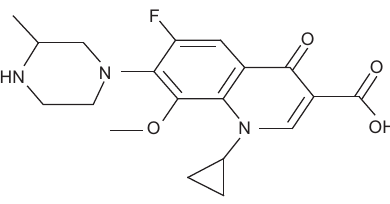
Figure 1 Structure of gatifl